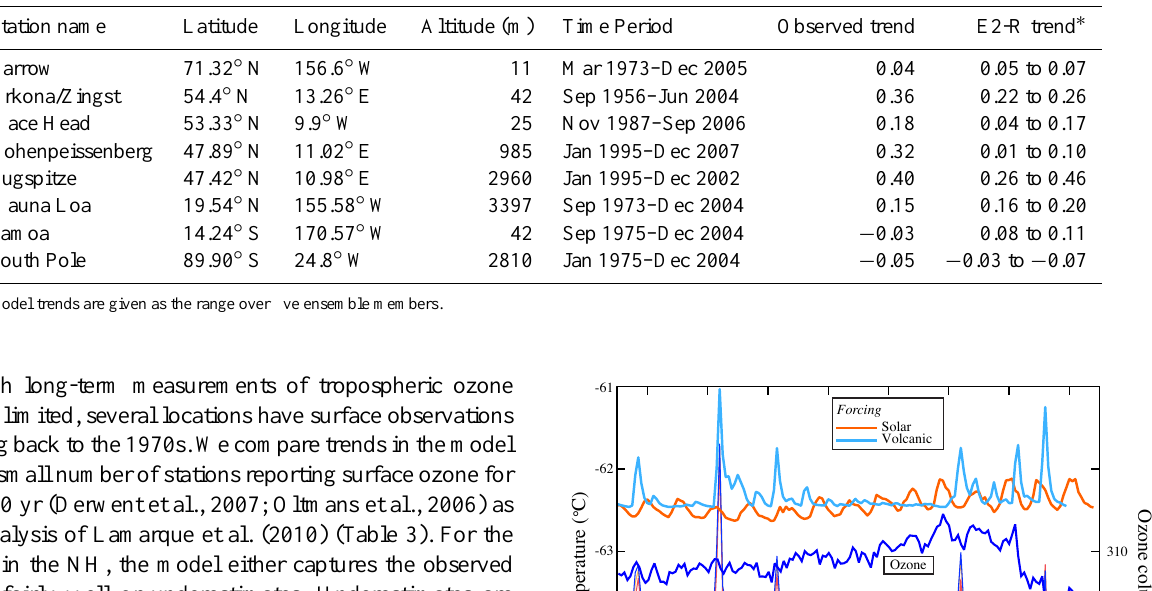
Table 3. Surface ozone trends (ppbv yr − 1 ) .